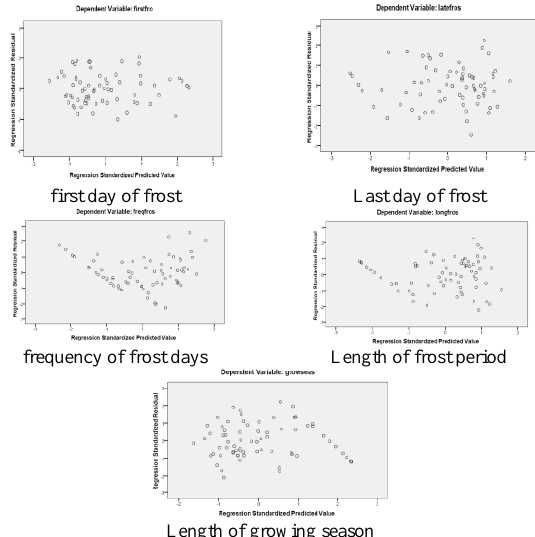
Figure 6: Scattering plots of standardized residual values against standardized predicted values for five statistical characteristics of frosts in